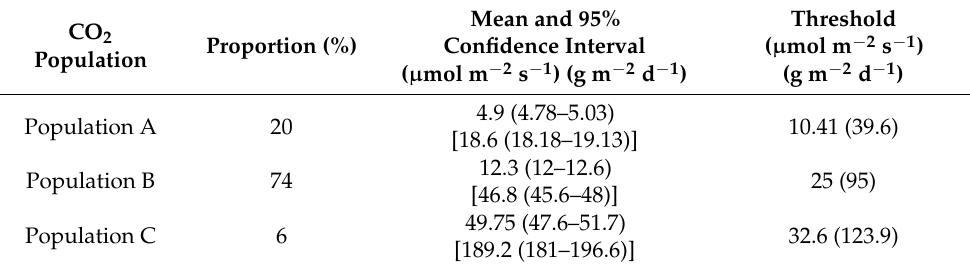
Table 2. Summary statistics of the partitioned